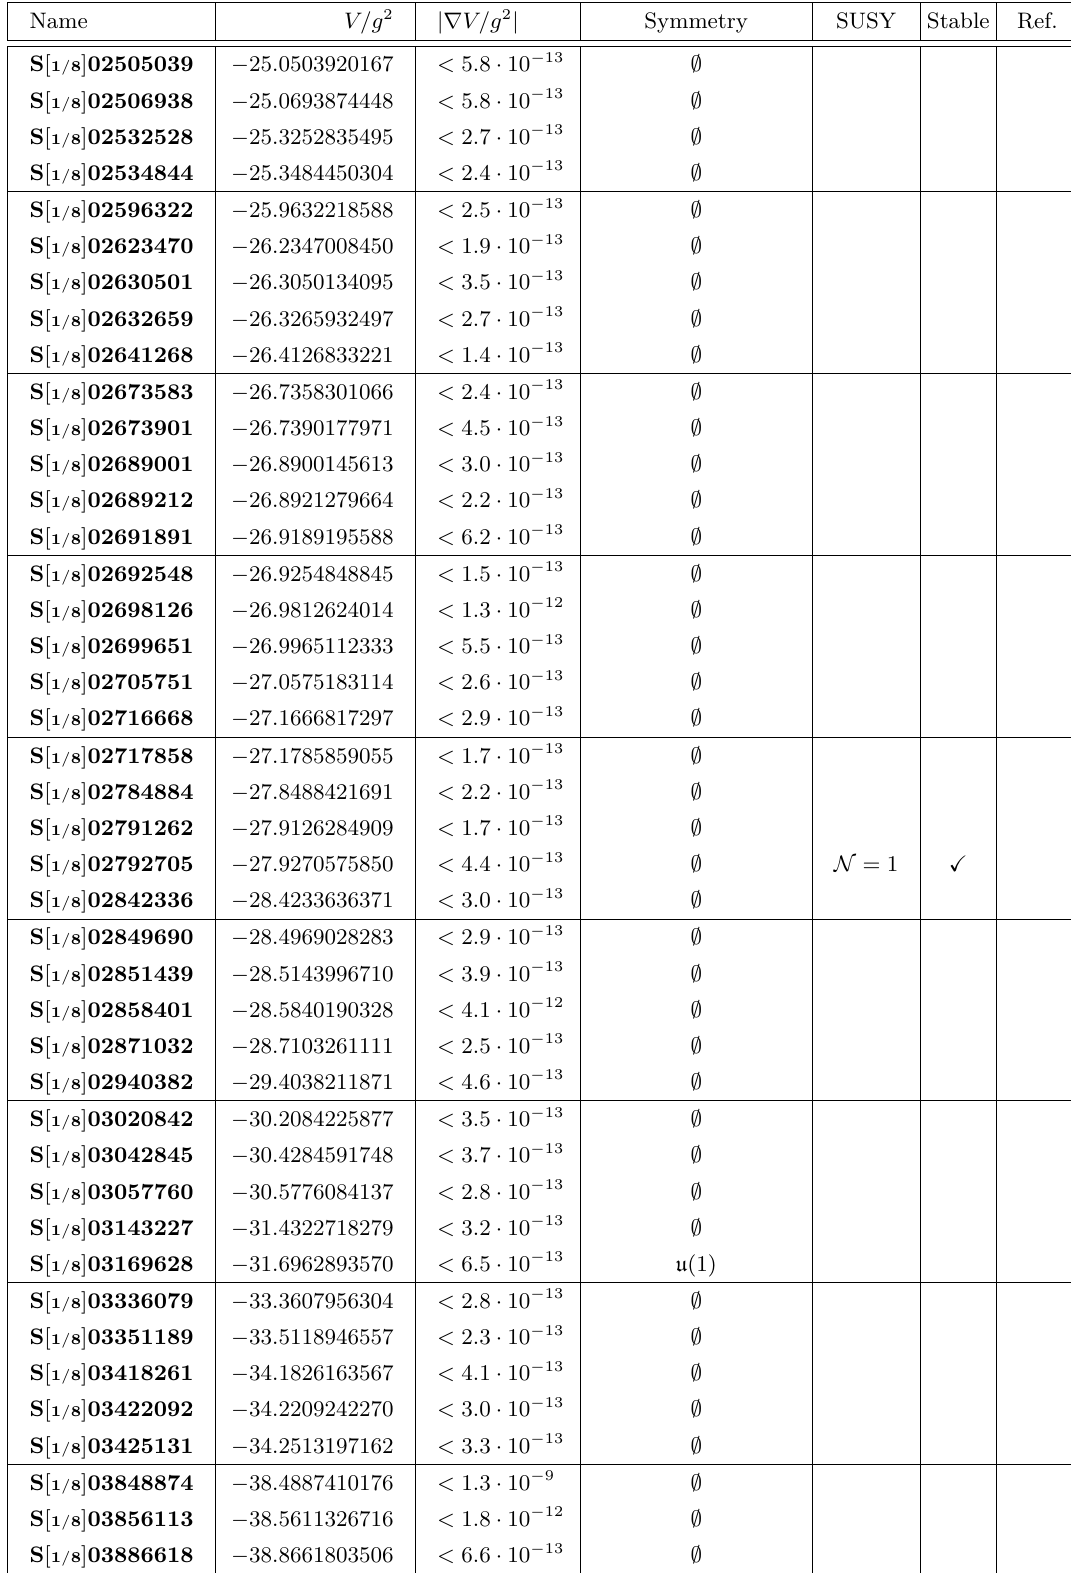
Table 1. Summary of vacua at ω = π/ 8